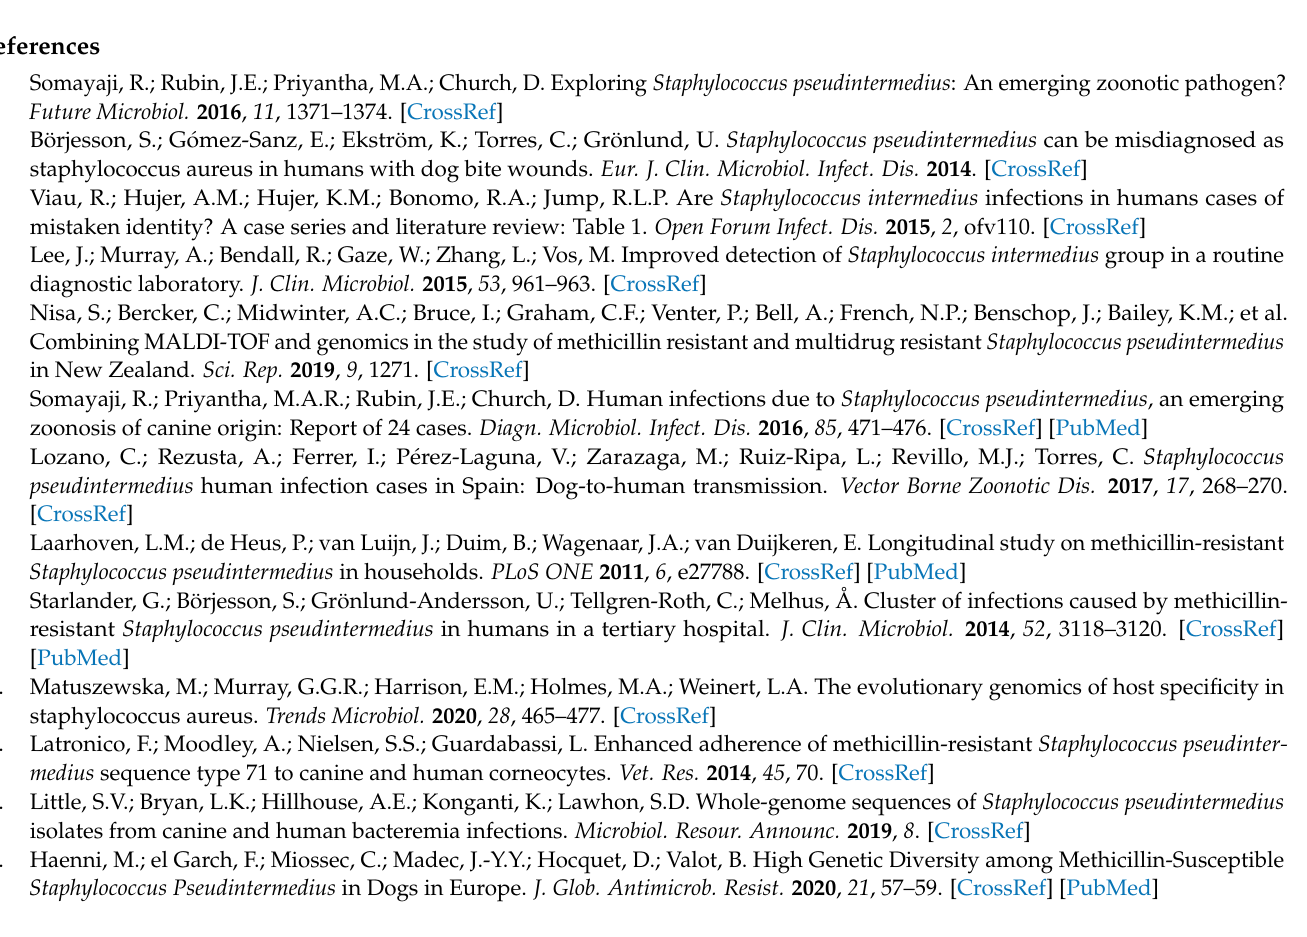
Table S3: Genome wide association study of CC241 defined with Roary-Scoary analysis. Figure S1: Tree of spsD genes of dog and humans. Figure S2: Tree of spsL genes of dog and humans. Figure S3: Phylogenetic tree of MSSP